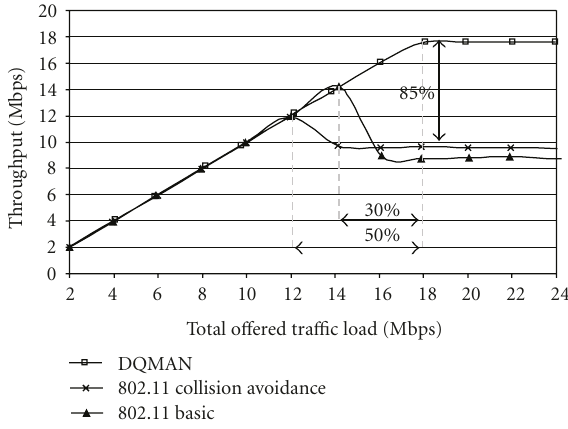
Figure 12: Throughput Comparison DQMAN versus 802.11.